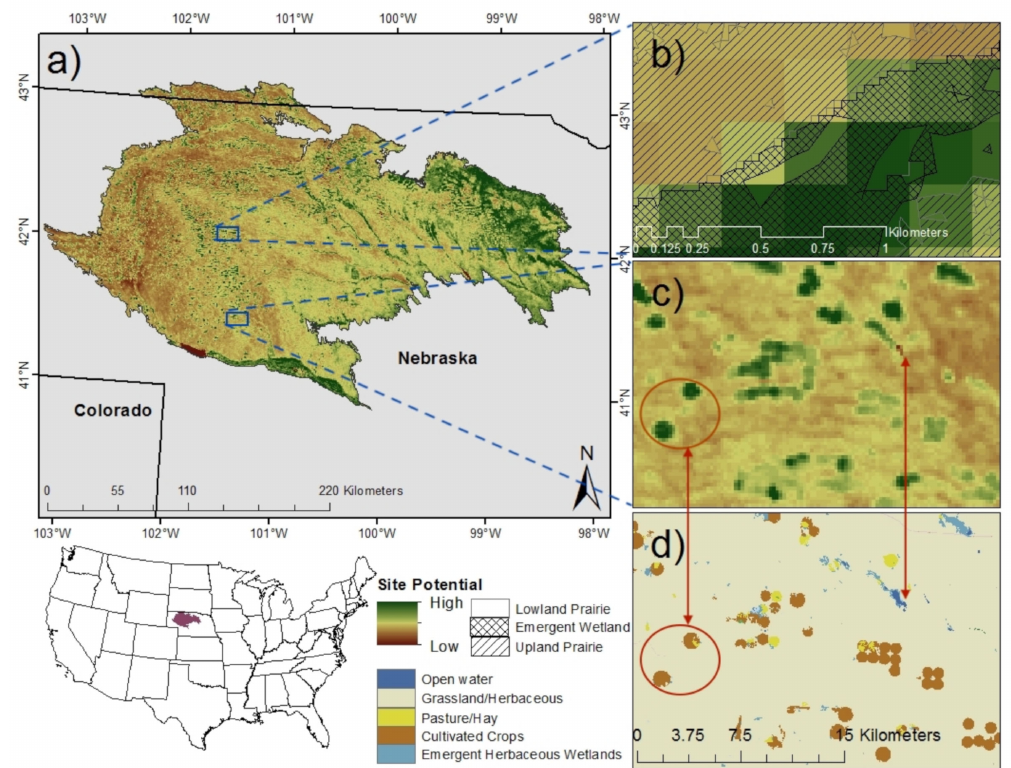
Figure 2. The Nebraska Sandhills study area with site potential that represents the inherit productivity of any location ( a ). We observed abrupt changes in productivity around areas of wet meadows ( b ) that are represented by emergent wetlands (cross-hatched areas) and by lowland prairie (unhatched areas) land cover (from Nebraska GAP land cover analysis) in contrast to upland prairie that is less productive (hatched areas). Other abrupt changes were observed for other land cover classes, especially irrigated agricultural areas (center pivots) or open water ( c , d